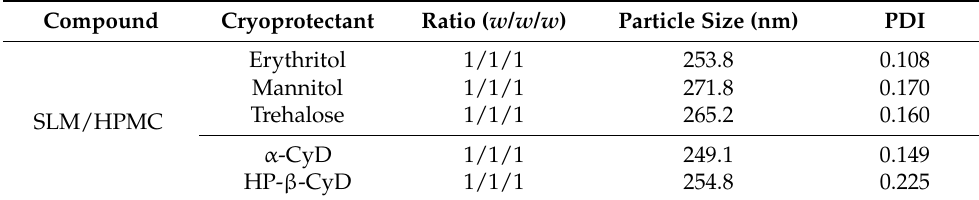
Table 4. Effect of cryoprotectants on particle sizes of silymarin/hypromellose nanoparticles (SLM/HPMC NPs) in the presence of various cryoprotectants.